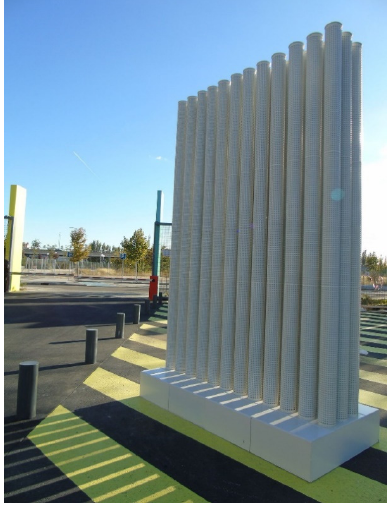
Figure 6. Prototype of a noise barrier based on sonic crystals.